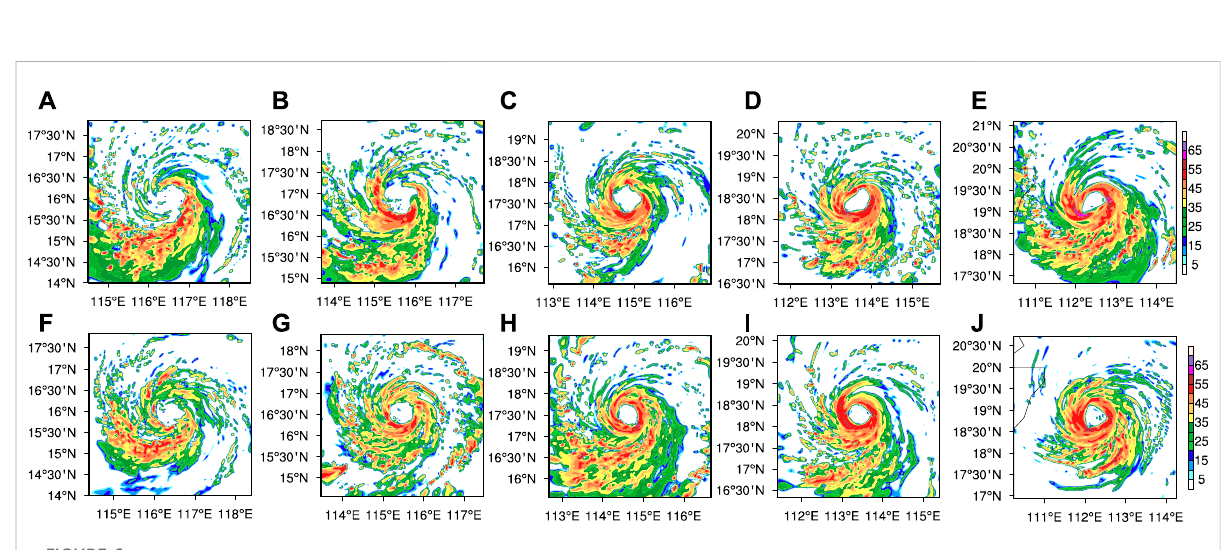
Radar re fl ectivity at 1 km altitude from 24-h integration to 48-h integration in the (A – E) control and (F – J) sensitivity experiments (Unit: dBZ) with time interval of 6